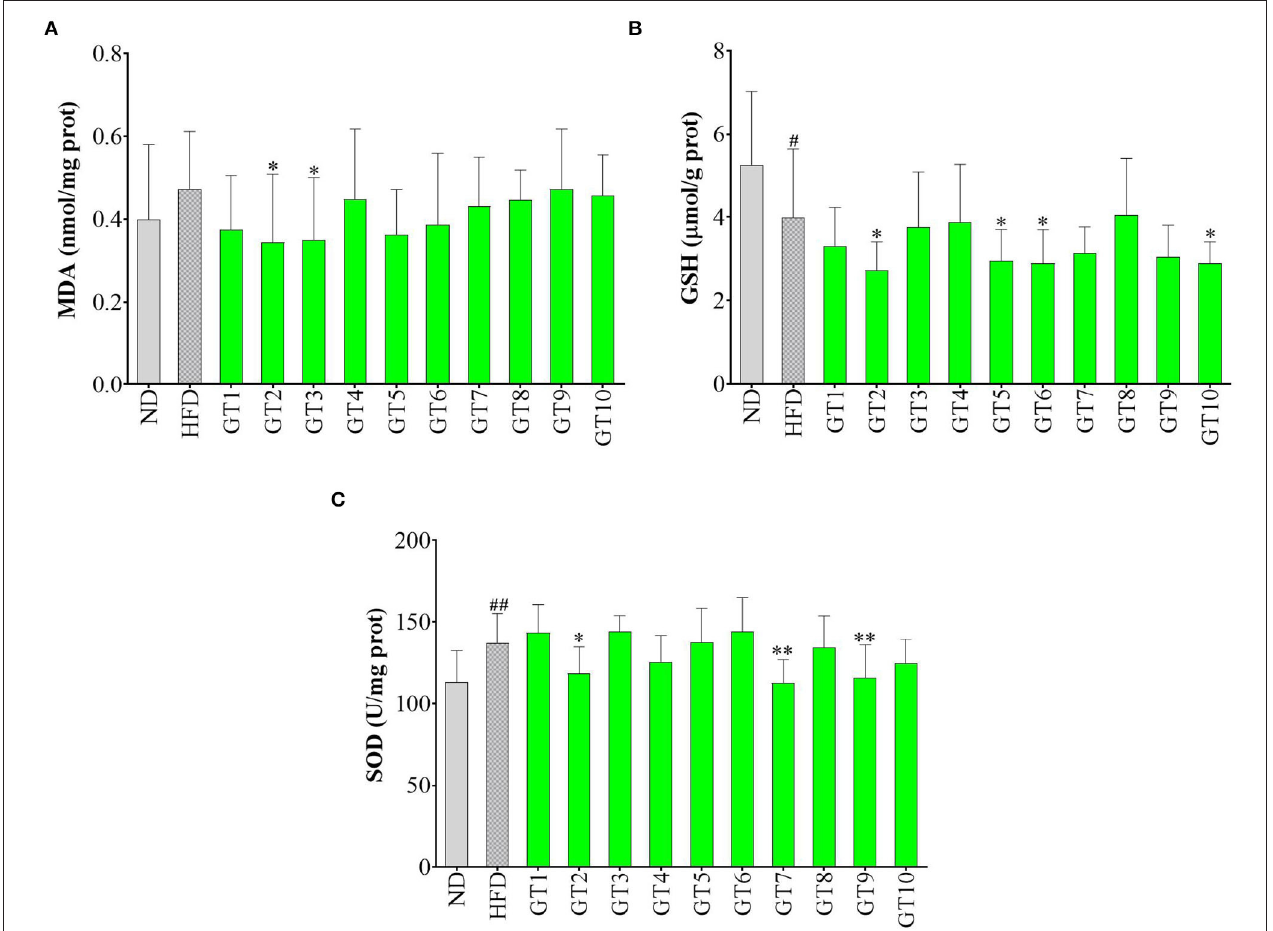
FIGURE 8 | Effects of green teas on hepatic oxidative stress. (A) Glutathione (GSH) ( µ mol/g protein); (B) superoxide dismutase (SOD) (U/mg protein); and (C) malondialdehyde (MDA) (nmol/mg protein). # p < 0.05, ## p < 0.01, the model group vs. the control group; * p < 0.05, ** p < 0.01, the green tea groups vs. the model group. GT1, Dianqing Tea; GT2, Jieyang Chaoqing Tea; GT3, Fenggang Zinc-Selenium-Enriched Tea; GT4, Liping Xiang Tea; GT5, Taiping Houkui Tea; GT6, Xihu Longjing Tea; GT7, Chaoqing Green Tea; GT8, Selenium-Enriched Chaoqing Green Tea; GT9, Selenium-Enriched Matcha; GT10, Seven Star Matcha.